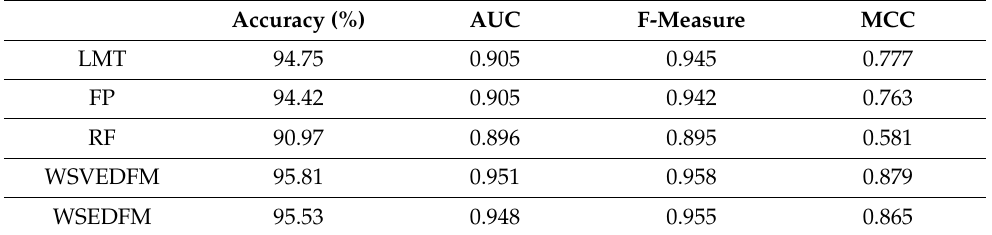
Table 7. The CCP performance of DF models and their Enhanced ensemble variants on original Dataset 1.